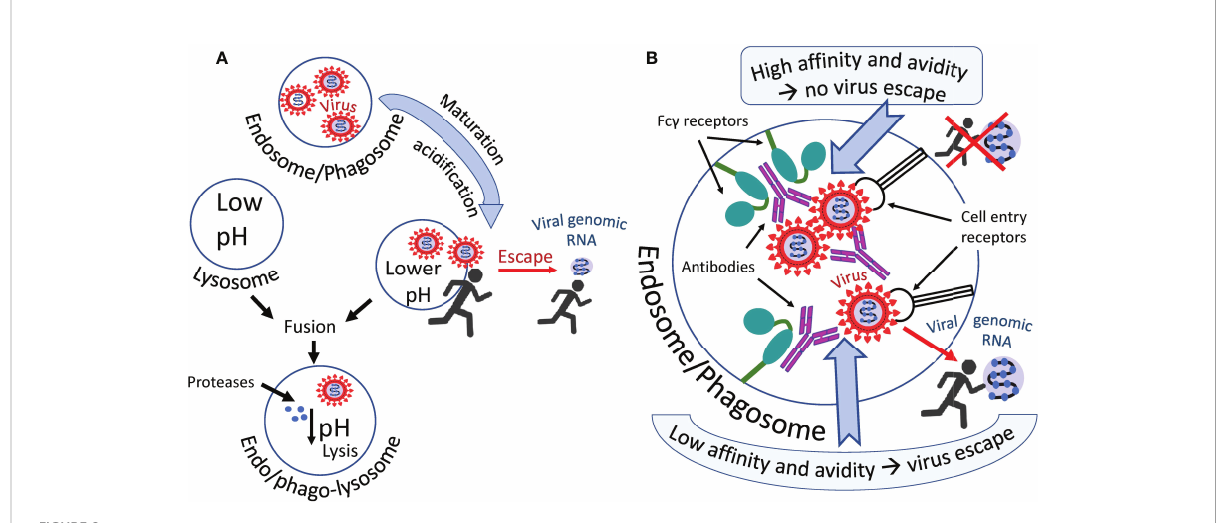
FIGURE 2 Hypothetical ways in which the virus escapes phagosomes. (A) The virus leaves the endosome/phagosome during its maturation and acidi fi cation. (B) Antibodies that fi rmly retain the virus in the immune complex most likely prevent it from leaving the organelle as shown in the upper part of the fi gure. Antibodies not fi rmly holding the virus allow it to escape from the organelle into the cytoplasm, as shown in the lower part of the fi gure. Perhaps acidi fi cation of the endosome/phagosome during its maturation reduces the af fi nity of some antibodies to the virus, promoting the exit of the virus from the immune complex and facilitating its exit from this organelle.